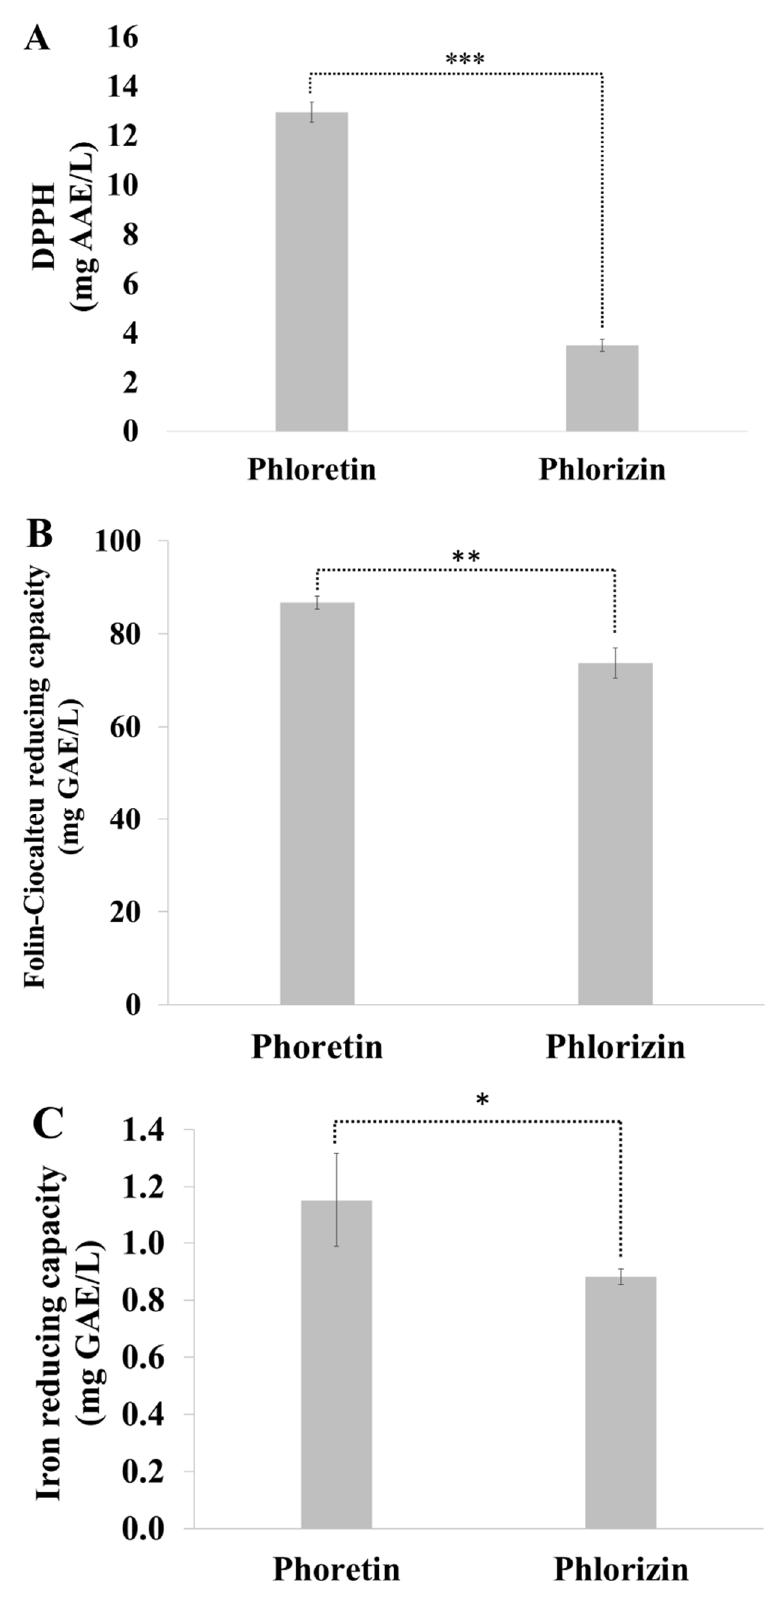
Figure 2. Antioxidant capacity of phloretin and phlorizin tested at 0.5 mmol/L using different in vitro assays: free-radical scavenging activity in relation to DPPH ( A ), Folin–Ciocalteu reducing capacity ( B ), and iron-reducing capacity ( C ). *** p < 0.0001, ** p < 0.001, * p < 0.05.